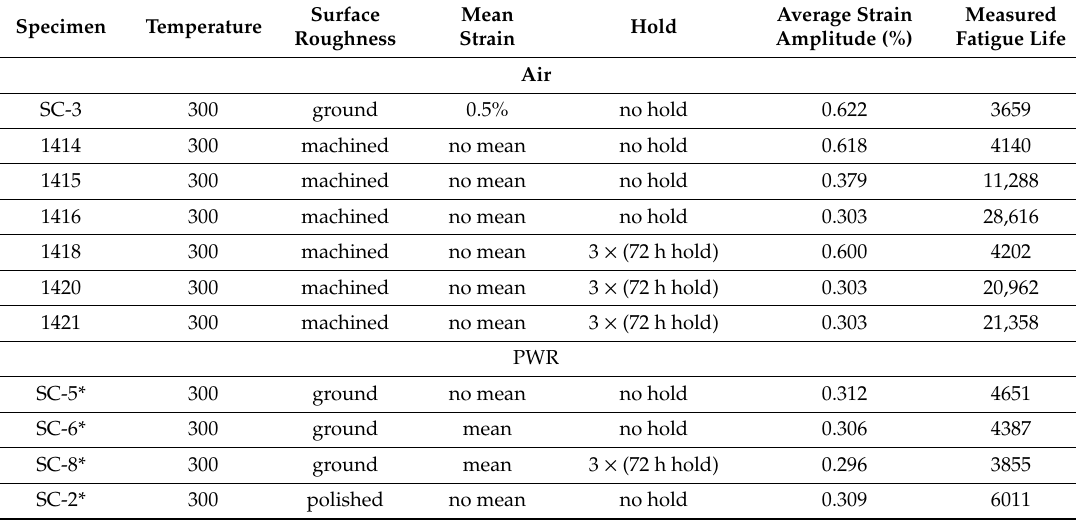
Table 5. N 25 results for strain-controlled, air and environmental, fatigue